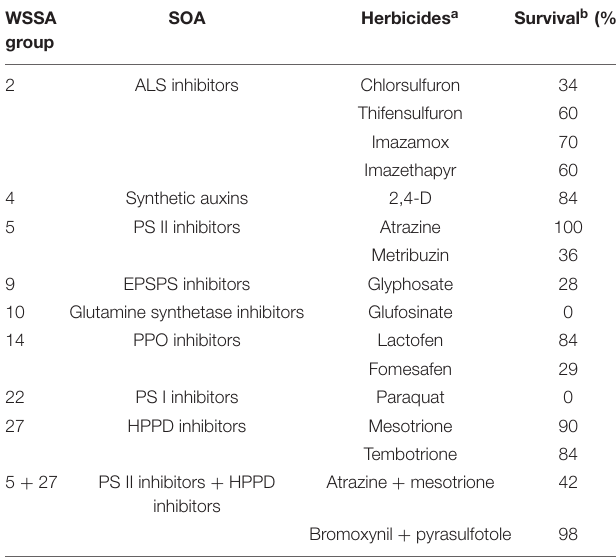
TABLE 2 | Percent survival of KCTR Palmer amaranth population to different post-emergence